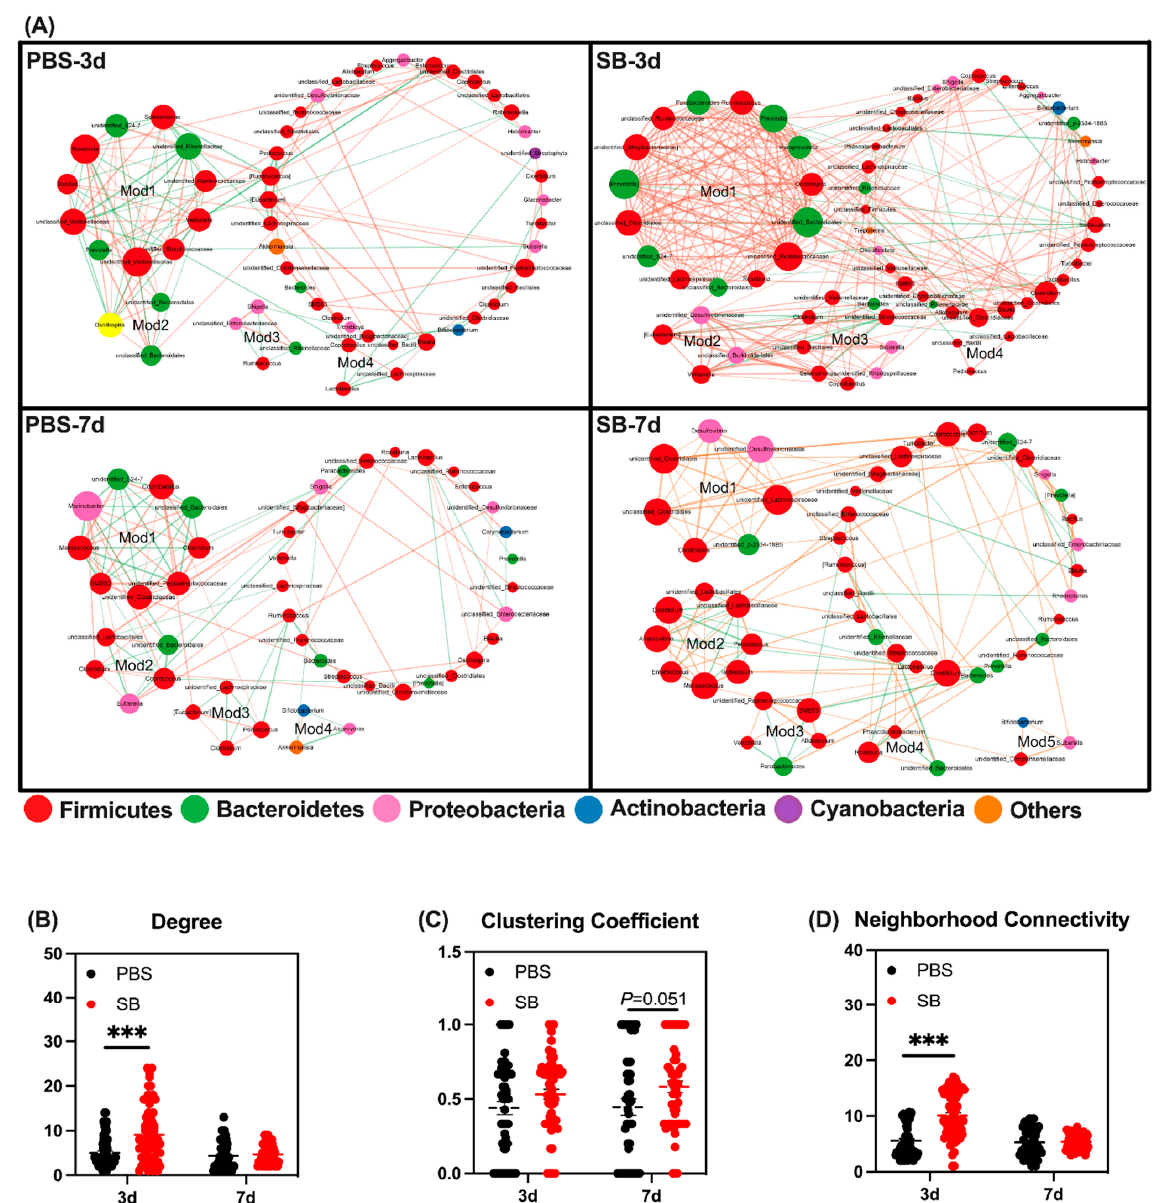
Figure 5. Effects of S. boulardii early intervention on microbial co-occurrence patterns. ( A )